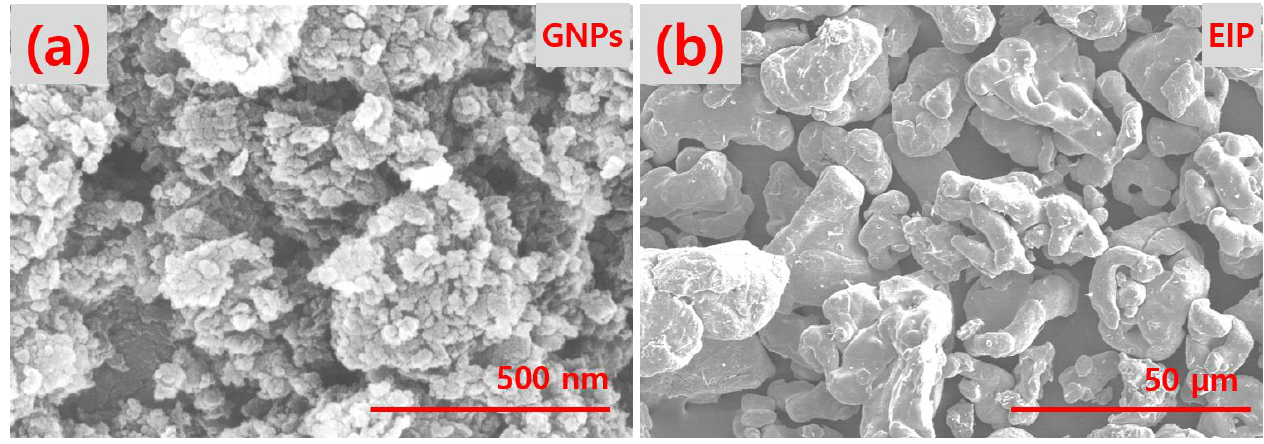
Figure 1. SEM images: ( a ) GNPs; ( b )